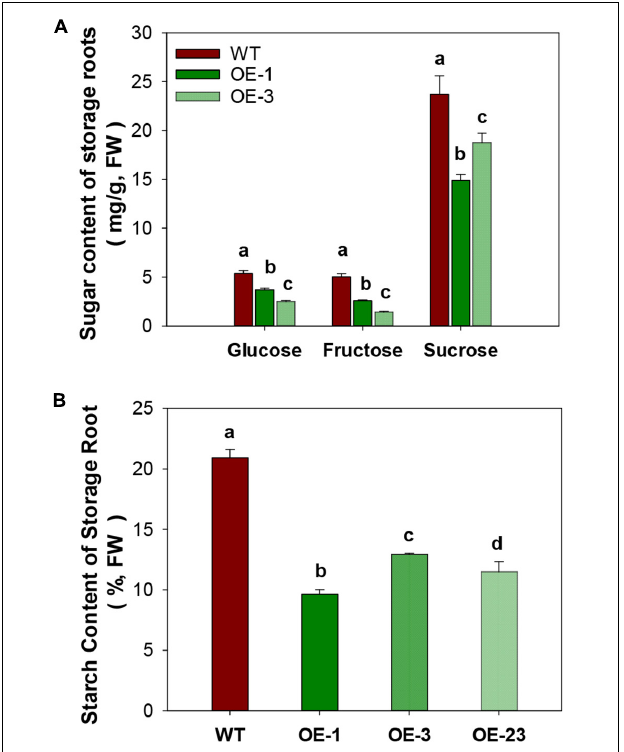
FIGURE 6 | Total sugar and starch content in storage roots of wild-type (WT) and the MeCWINV3 -overexpressed (OE) cassava plants. (A) Contents of glucose, fructose, and sucrose. (B) Starch contents. Different letters indicate significant differences (one-way ANOVA, p <